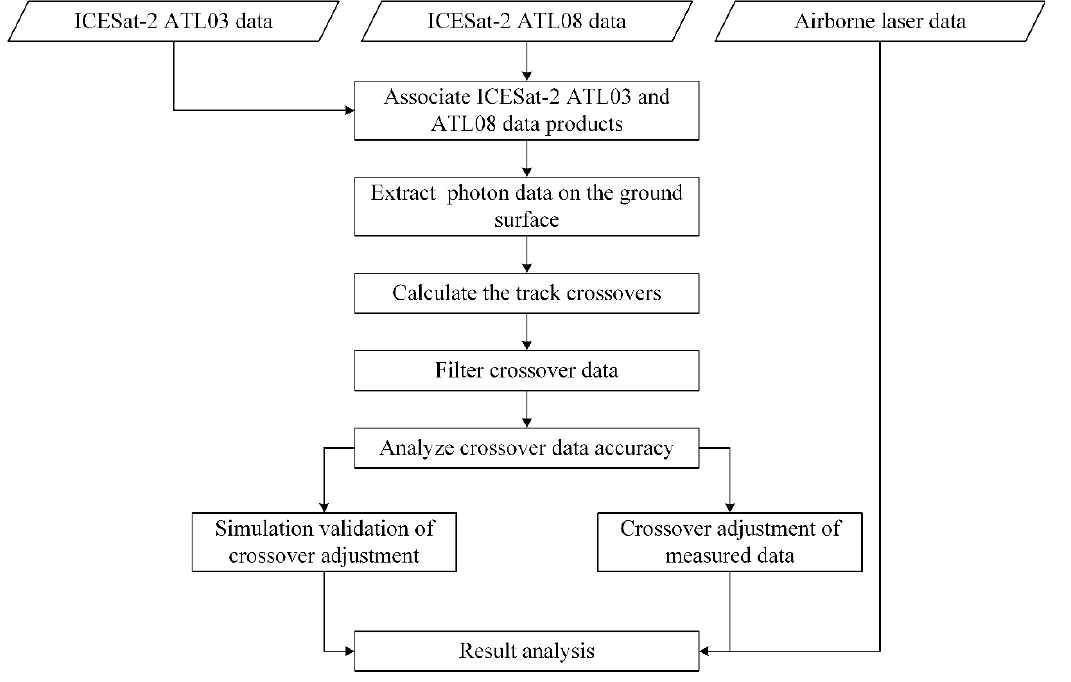
Figure 4. Flow chart of the crossover analysis.